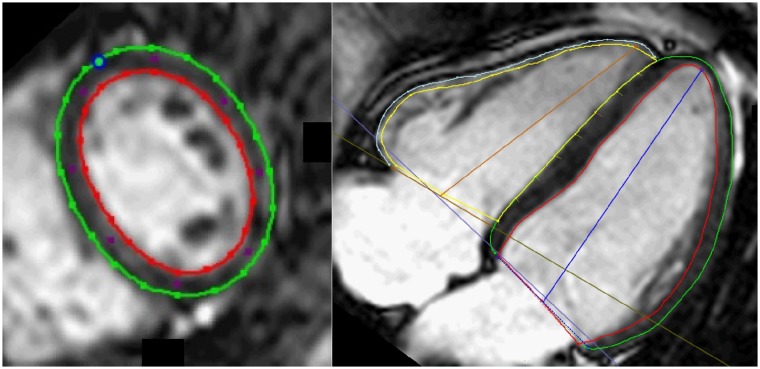
Example of delineations in one slice from a short axis stack (left) and 4-chamber long axis view (right).Green line represents left ventricle epicardial border, red line represents left ventricular endocardial border. Blue circle represents the insertion point in the short axis between the right and left ventricle and blue lines represent left ventricle atrioventricular plane and ventricular axis to the apex. Yellow line represents right ventricle endocardial border, light blue line represents right ventricle epicardial border and the brown line represents the right ventricle atrioventricular plane and ventricular axis to the apex.